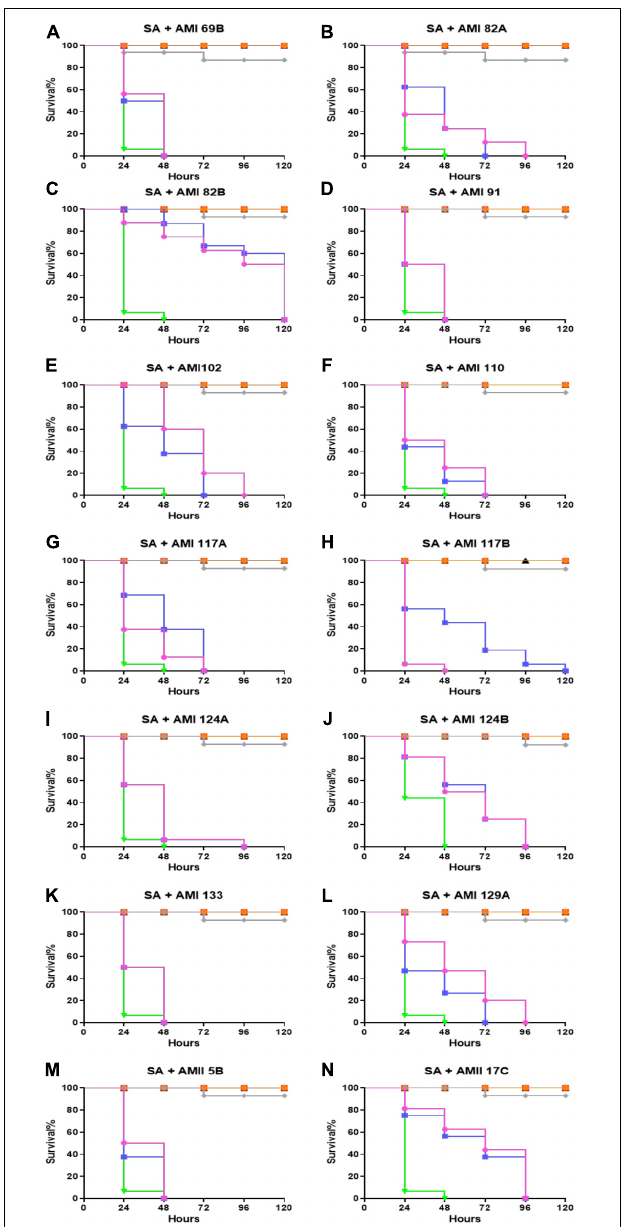
FIGURE 3 | Whole larvae survival assay for efficacy assessment of the test compounds. Plotted here (A–N) are the survival profiles of selected compounds. Legend